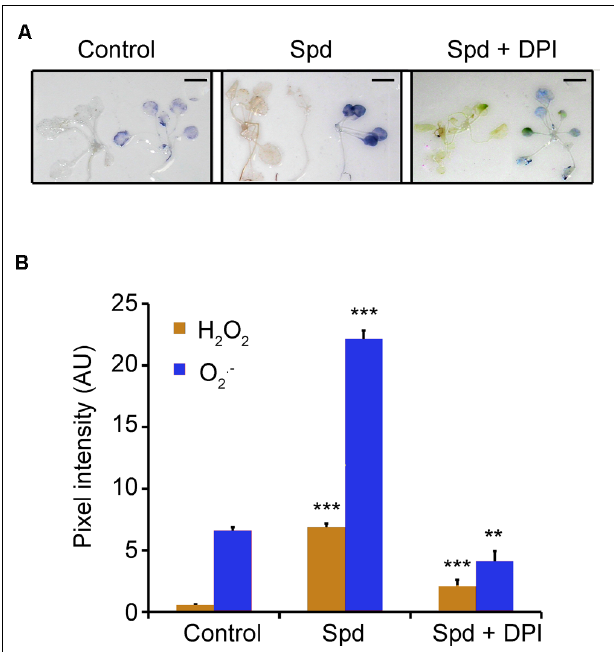
FIGURE 2 | Effect of exogenous Spd and DPI on ROS homeostasis in Arabidopsis plants. (A) Plants were treated with 1 mM Spd for a period of 10 min and H 2 O 2 or O •− 2 were estimated by in situ detection methods. Scale bars, 2.8 cm. (B) Relative pixel intensity of the brownish (detection of H 2 O 2 ) or bluish (detection of O •− 2 ) adduct formed after application of 1 mM Spd. AU, arbitrary units. Data are the means of three independent experiments ± SD. Asterisks indicate statistical significant differences (*** P < 0.001; ** P < 0.01). effect of Spd on respiration. Spd was added in combination with